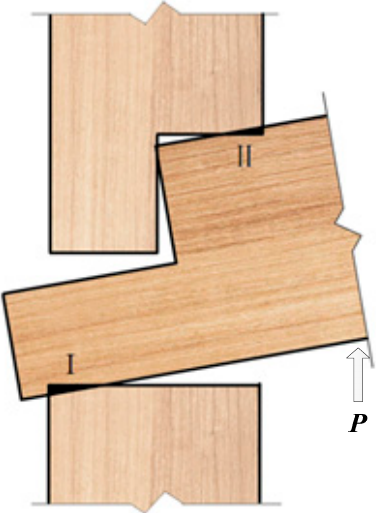
Figure 8. Rotation of timber frame under external load.